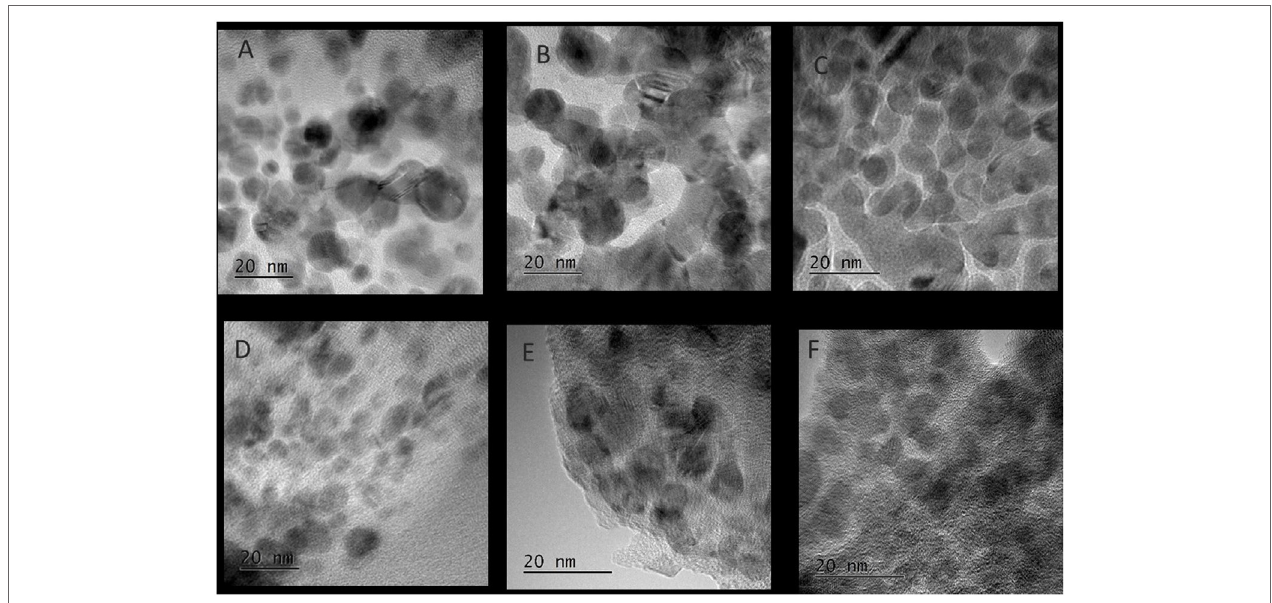
FigUre 6 | TEM images of Cu nanoparticles after low-temperature methanol synthesis reaction in the different solvents, (a) diethyl ether, (b) glyme, (c) tetraglyme, (D) tetrahydrofuran, (e) acetonitrile, (F) dimethyl sulfoxide.